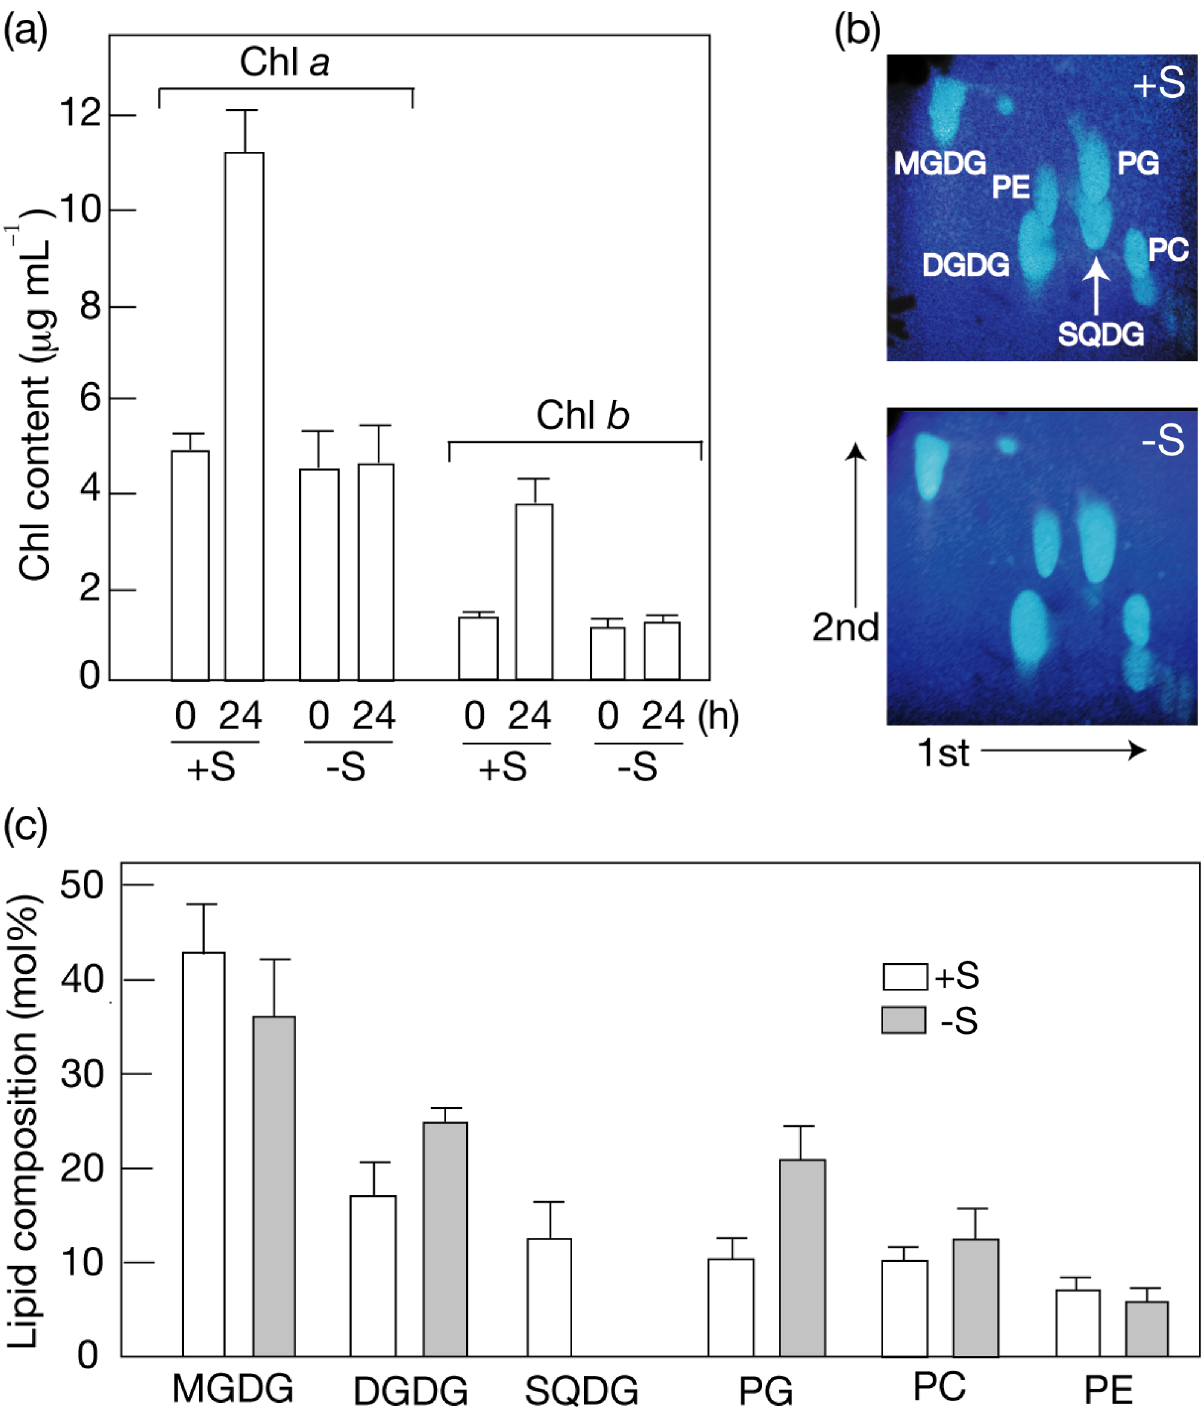
Fig 1. Effects of S-starvation on Chl and lipid contents in C . kessleri . (a) The respectivecontents of Chl a and b are shown after a shift of normallygrown cells to S-replete(+S) or S-starved (-S) conditions for further growth for 1 day. (b) Profiles of polar lipidsfrom +S and -S cells on two-dimensionalTLC. The solvent systems used for development of total cellularlipidswere CH 3 Cl/CH 3 OH/H 2 O (130:50:8by vol.) and CH 3 Cl/CH 3 OH/conc. NH 3 solution (130:70:10by vol.) for the 1 st and 2 nd dimensions, respectively. (c) Polar lipid compositions of +S (open bars) and -S (grey bars) cells. MGDG, monogalactosyl diacylglycerol. DGDG, digalactosyl diacylglycefrol. PC, phosphatidylcholine. PE, phosphaidylethanolamine.The values shown are the averages ± SD for three distinct groupsof data.